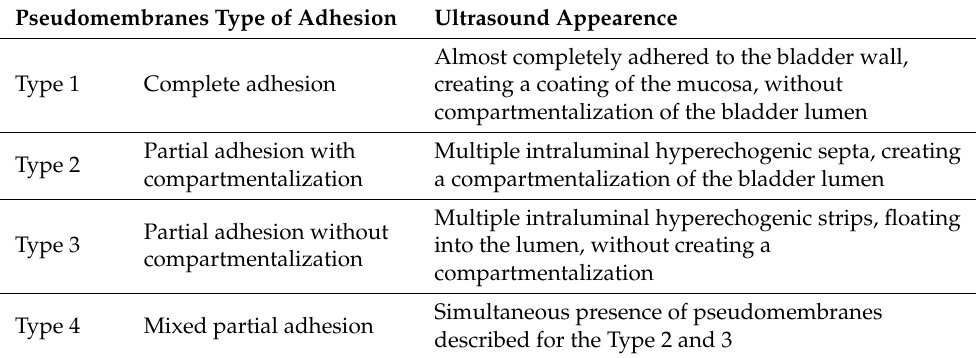
Table 1. Types of adhesion of the pseudomembranes to the bladder wall and ultrasound appearance. Pseudomembranes Type of